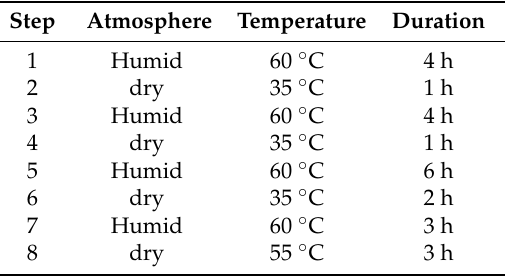
Table 3. Test conditions in climatic